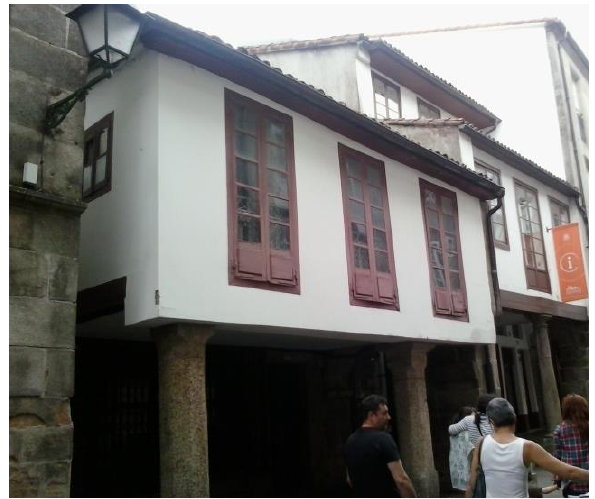
Figure 13. Housing with arcades in the Rúa Nova in Santiago de Compostela. Another example of how the timber frame typology evolved, conserving the arcade but increasing the façade openings. Source: A.F.P.